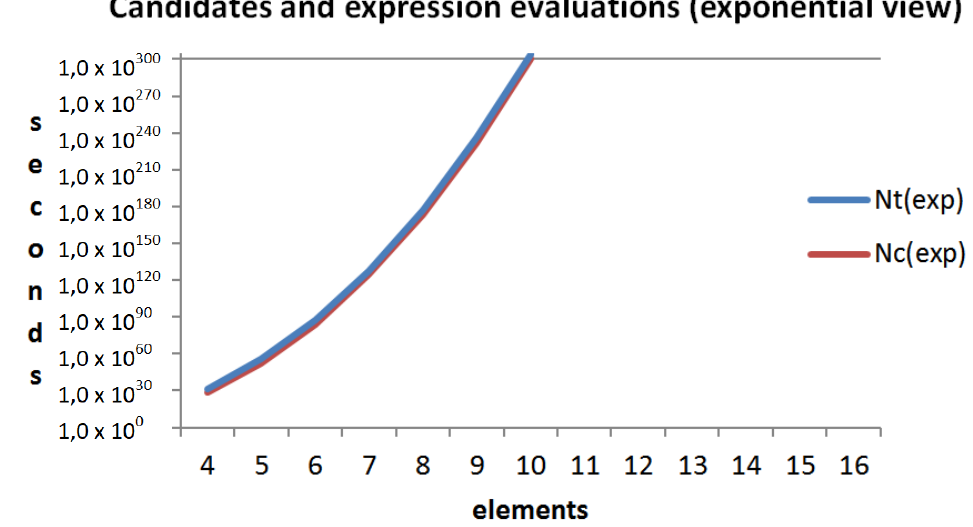
Figure 1. Superexponentiality of the problem (time—seconds vs.